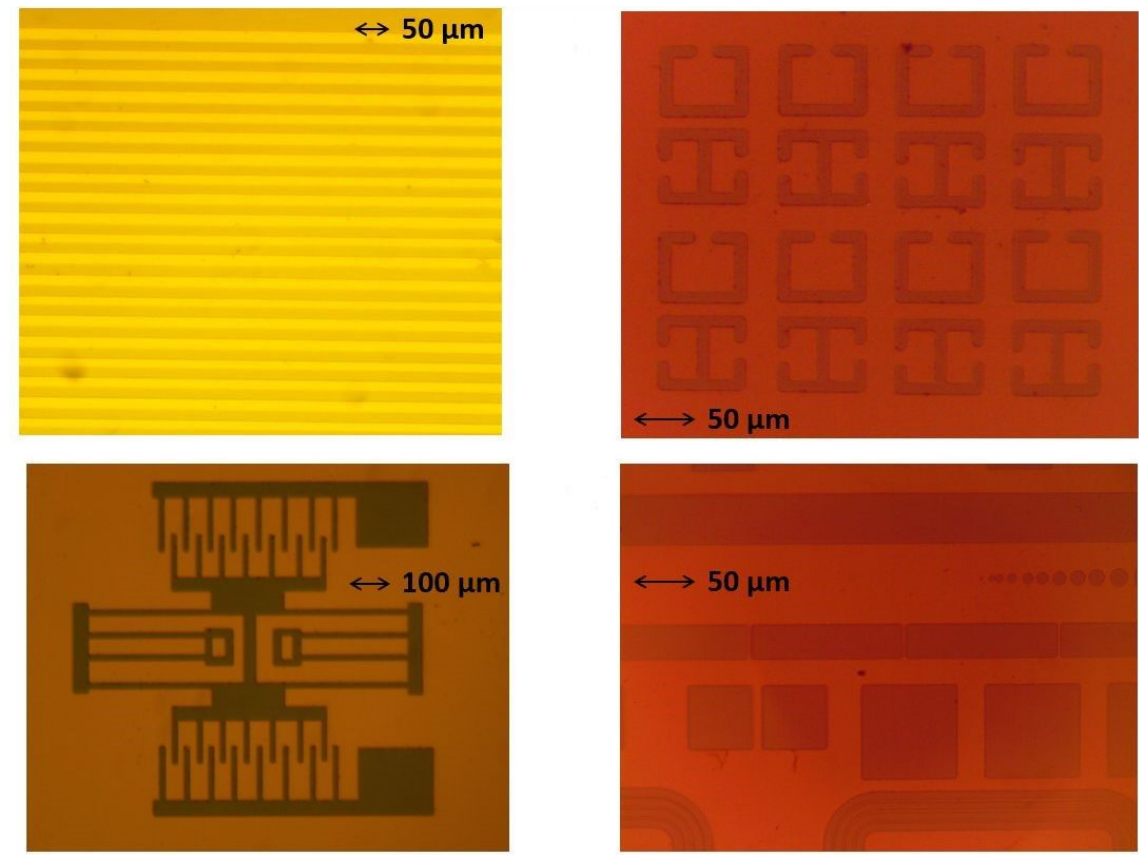
Figure 3. Various designs transferred onto the tungsten mask on silicon substrates. These images correspond to step 6 in Figure 1. SEM imaging of the B-C microstructures revealed a similar crystalline structure as observed from the thin-film form of the B-C material [3]. Figure 4 shows the SEM images from various samples we grew. The top row shows a grid of microstructures whose de- sign was inspired by the RF ring resonator structures. In the middle row, a compact grid of B 50 C 2 microstructures is displayed. Well-controlled patterns with features as small as 10 microns in width were reliably grown on the silicon substrates. The bottom row shows the SEM images of the B-C microstructures which were grown in the geometry of a typical MEMS resonator design.